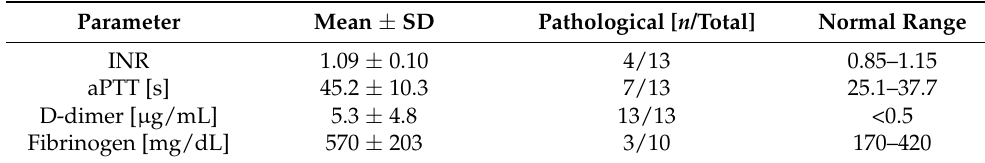
Table 1. Routine coagulation parameters of the COVID-19 cohort.